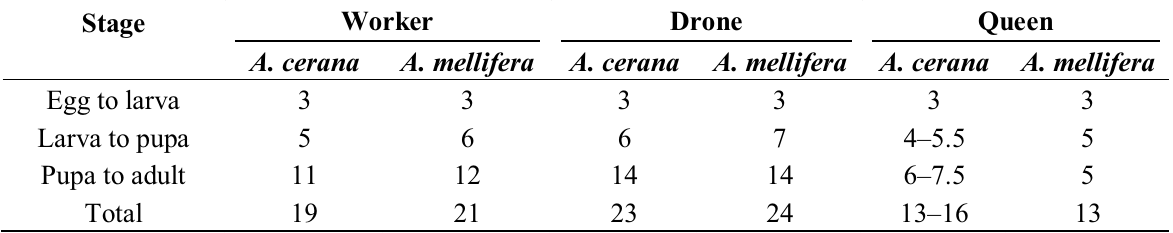
Table 1. Duration of the life cycle (days) of different castes of A. cerana and A. mellifera modified from